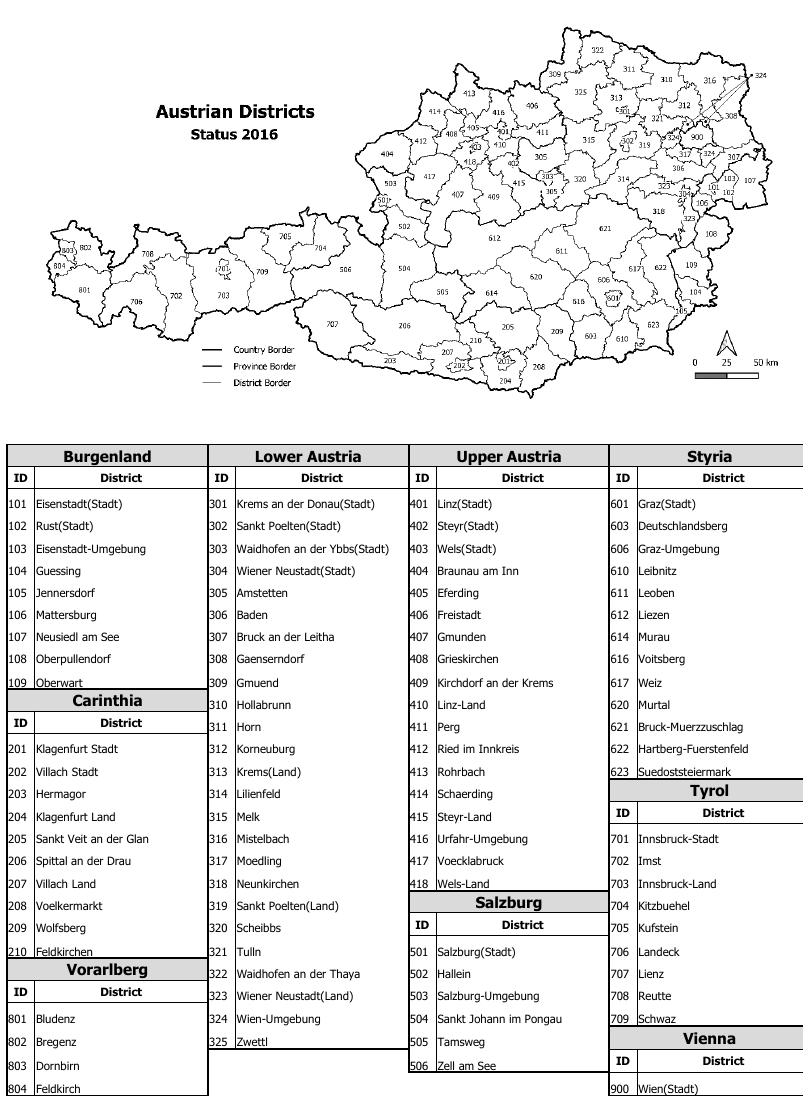
Figure B1. Overview of all Austrian districts including the allocation to the provinces (map source: Statistics Austria - data.statistik.gv.at).